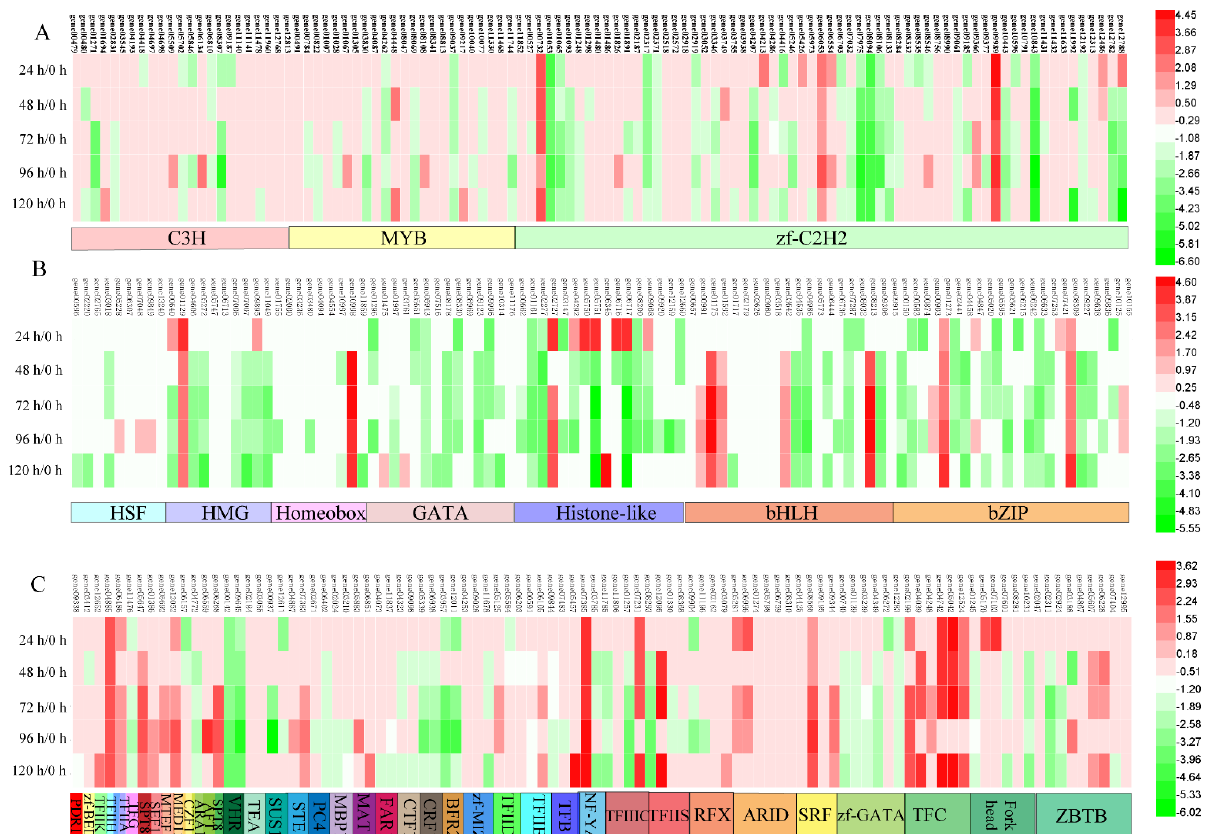
Figure 3. Heat map of expression profiles (in log2 − based FPKM) of TF genes in yeast YF1503. The expression abundance of each transcript is represented by the color of the bar, with green indicating a low level and red indicating a high level. ( A ) The expression profiles of zf-C2H2, MYB and C3H family TF genes. ( B ) The expression profiles of HSF, HMG, Homeobox, GATA, Histone-like, bHLH and bZIP family TF genes. ( C ) The expression profiles of PDR1, zf-BED, TFIIK, TFIIH, TFIIA, TFG, SPT8, SEF1, MTEF1, MED13, CZF1, ARA1, AFT, VHR1, TEA, SUS1, STE, PC4, MBP1, MAT1, FAR1, CTF1, CRF1, BFR2, zf‑MIZ, TFIID, TFIIB, TFB, NF‑YA, TFIIIC, TFIIS, RFX, ARID, SRF, zf‑GATA,